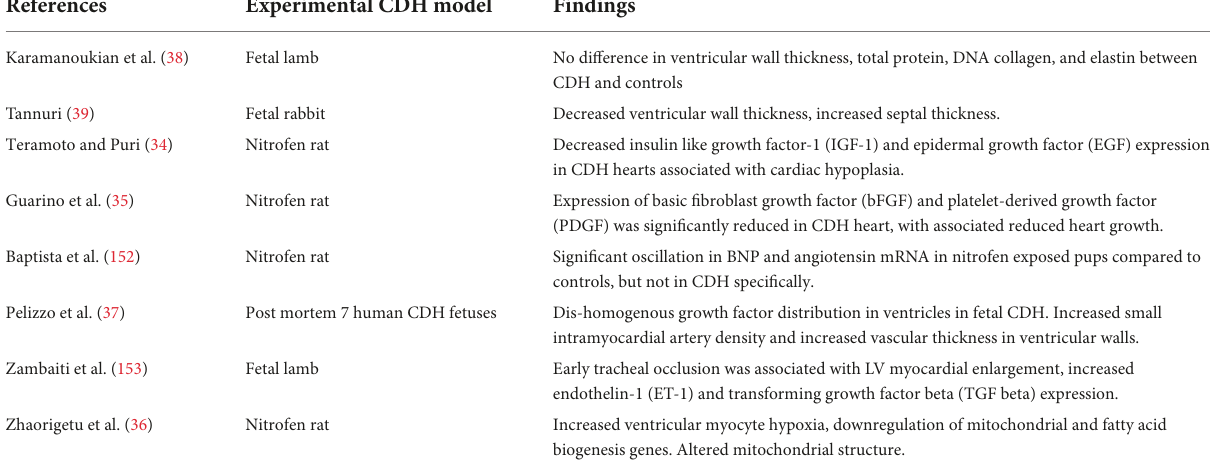
TABLE 2 Studies of fetal cardiac cellular structure and metabolism in